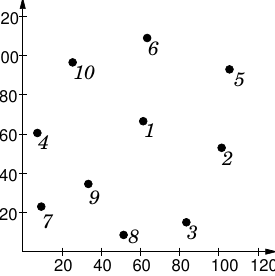
Figure 1. Example instance “ tsp10 ” with 10